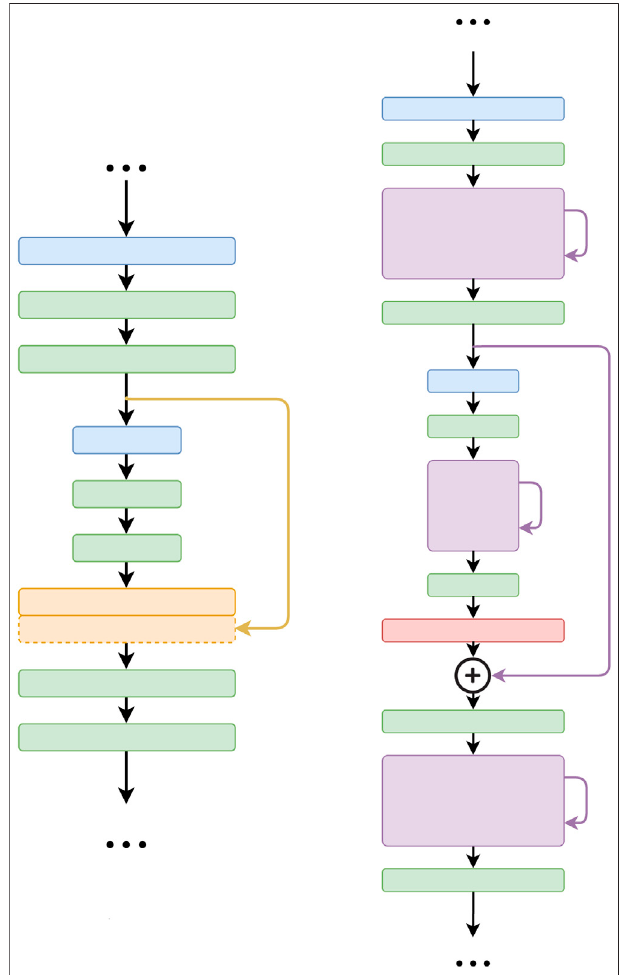
FIGURE 3 | Difference between the core connections of U-net (Ronneberger et al., 2015) (left) and FusionNet (right) . Note that FusionNet is afullyresidualnetworkduetothesummation-basedskipconnectionsandisa much deeper